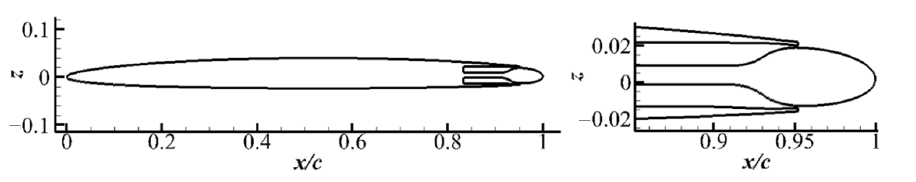
Figure 1. Elliptical airfoil with Coanda